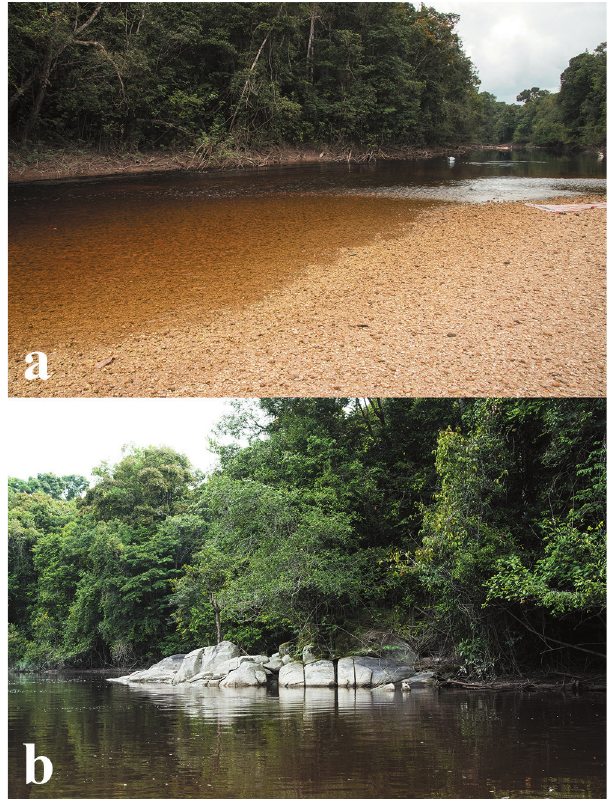
Fig. 5. Collection localities for Myloplus taphorni . a. Eping Creek; b. Type locality, Lower Kurupung River near the mouth. Both streams are tributaries of the middle Mazaruni River, Guyana. Photos: